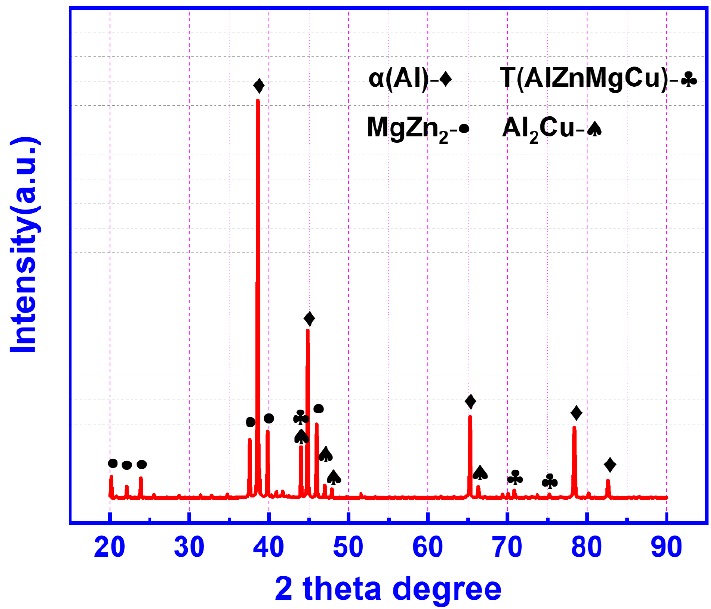
Figure 3. XRD patterns of t he as-cast 13Zn alloy.